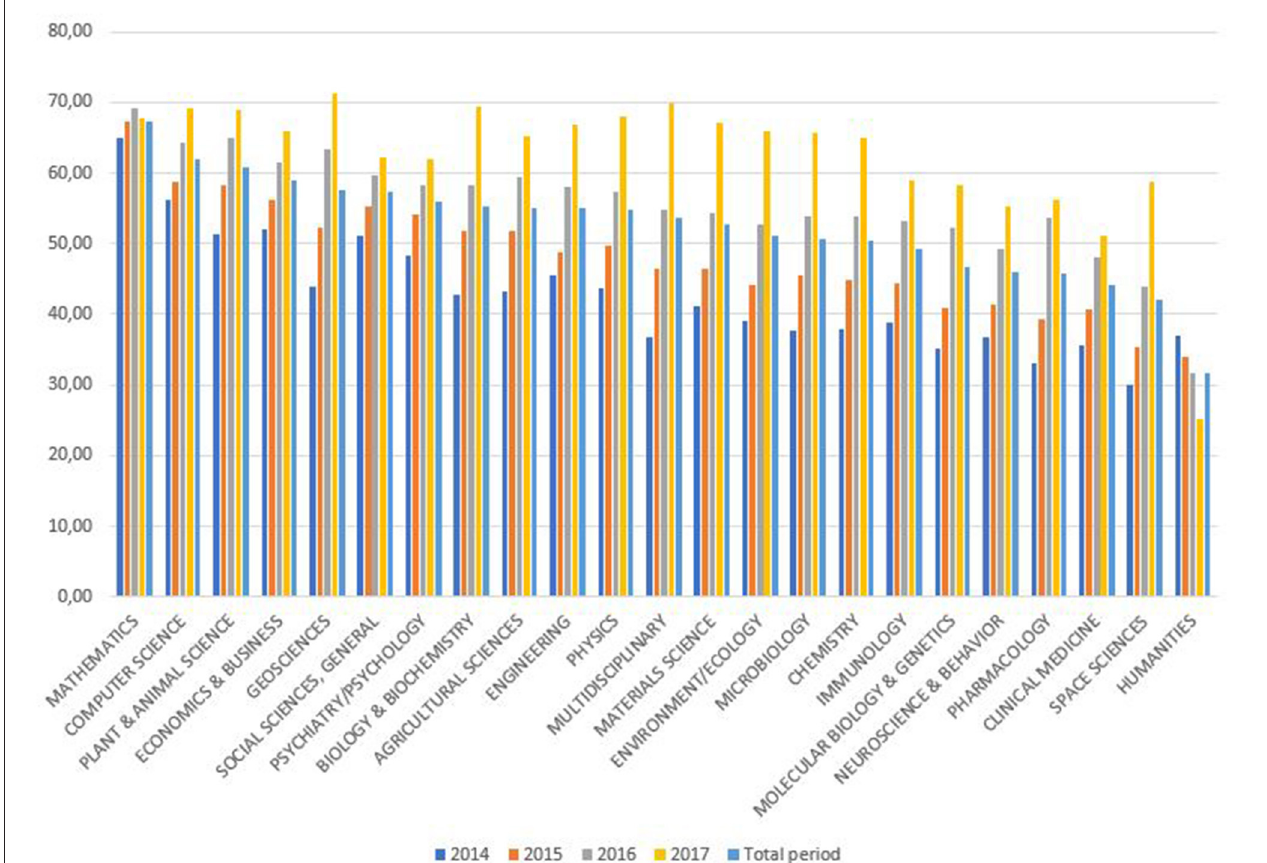
FIGURE 3 | Percentage of less-citedness in SUPE by Incites/Essential Science Indicators area.